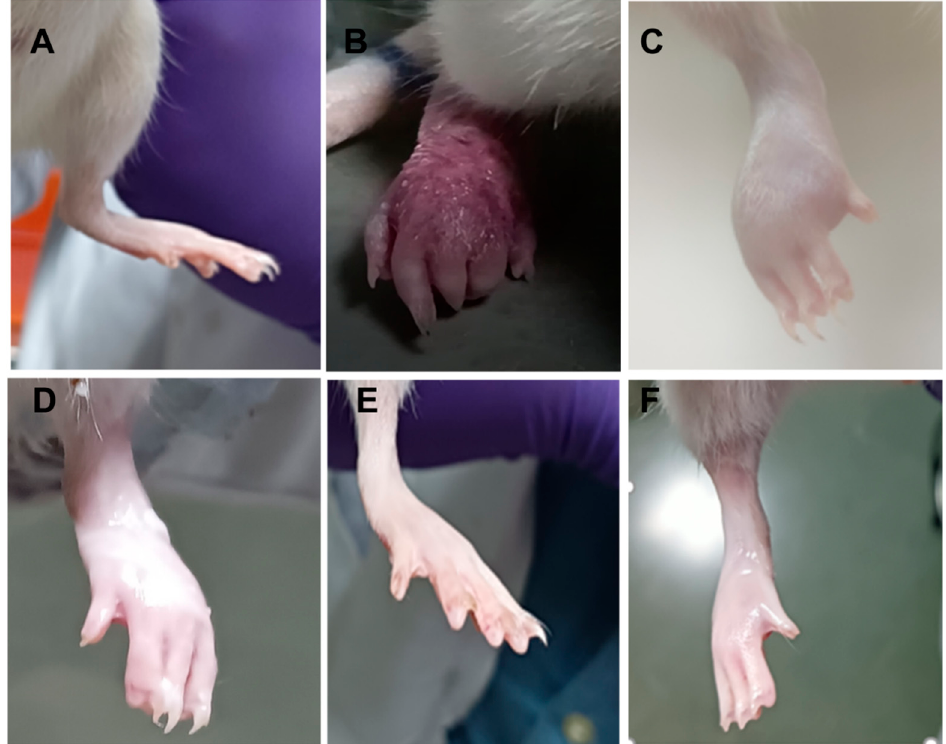
Figure 14. Representative images of FCA injected hind paws after 28 days of treatment with various formulations: ( A ) normal; ( B ) AIA; ( C ) CF018P emulgel; ( D ) FDG; ( E ) CF018 emulgel; ( F ) MFD .